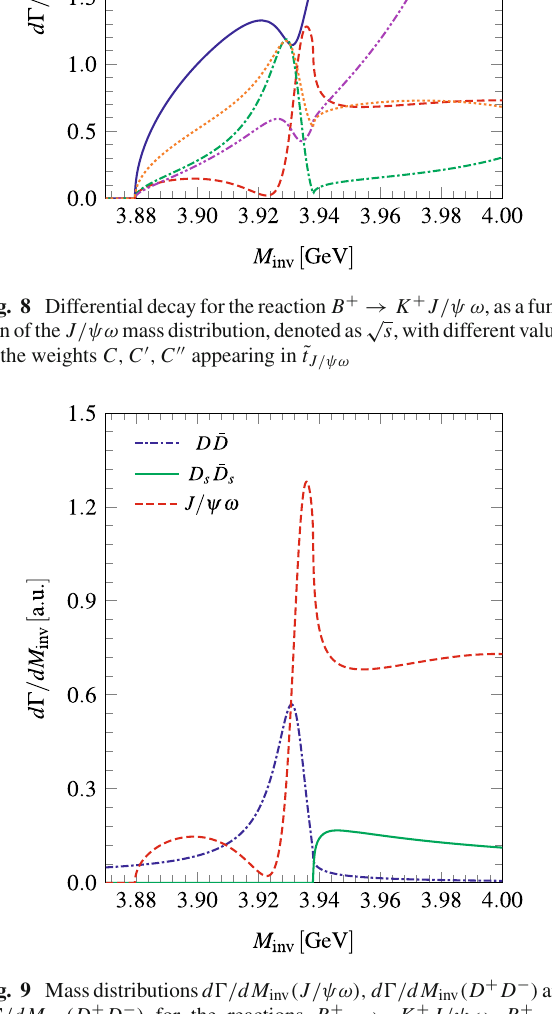
Fig. 9 Massdistributions d (cid:4)/ dM inv ( J /ψω), d (cid:4)/ dM inv ( D + D − ) and d (cid:4)/ dM inv ( D + s D − s ) for the reactions B + → K + J /ψ ω , B + → K + D + D − and B + → K + D + s D − s , respectively. The last two